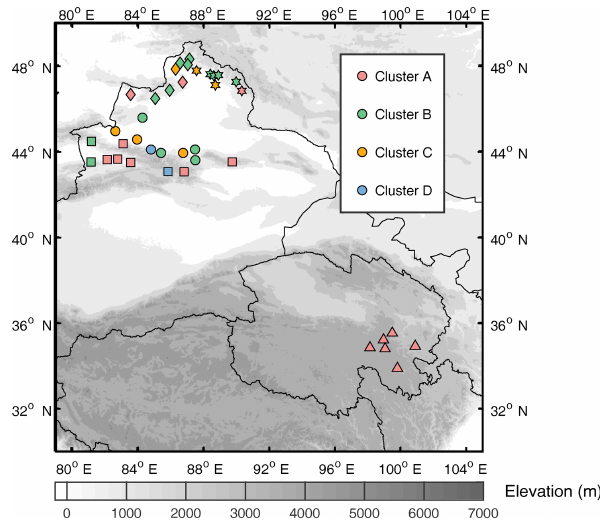
Figure 6. Hierarchical cluster analysis based on the relative contri- butions of fluorescent